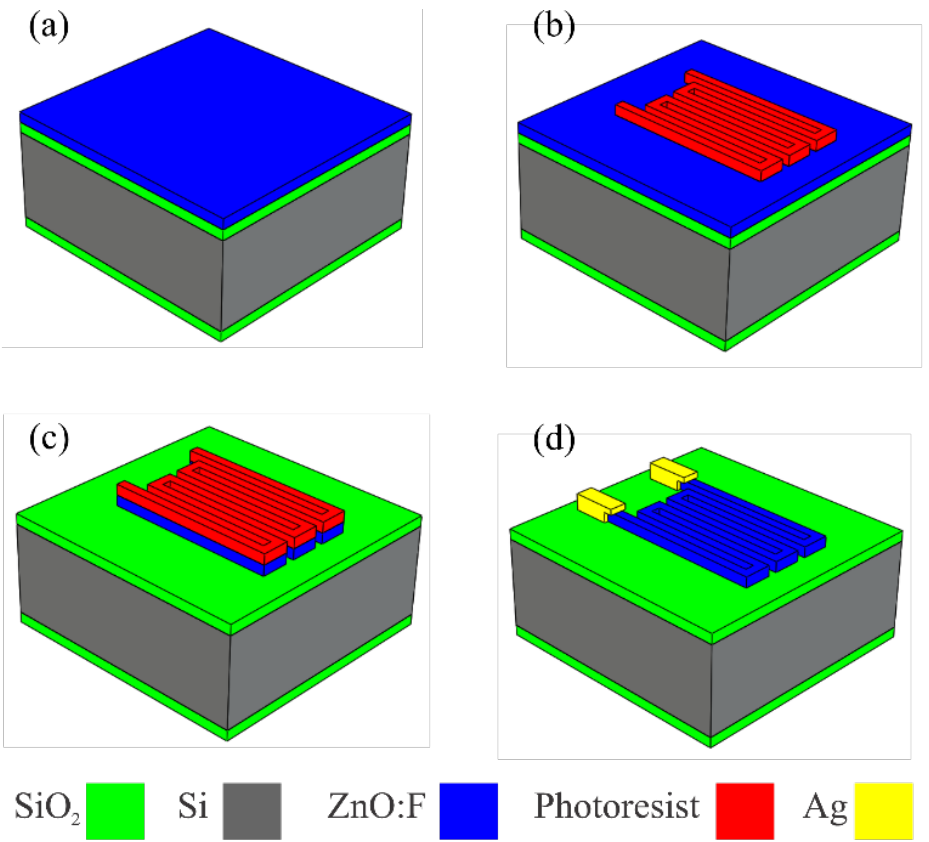
Figure 1. Piezoresistor manufacturing process: ( a ) deposition of a ZnO:F thin film via ultrasonic spray pyrolysis; ( b ) photoresist deposition with spin coating and piezoresistor pattern formation with lithography; ( c ) chemical etching with H 3 PO 4 + CH 3 COOH + H 2 O (1:1:50) for resistance formation; ( d ) placement of conductive Ag paste contacts (Sigma Aldrich 735825-25G, resistivity 10 − 5 Ω.cm).